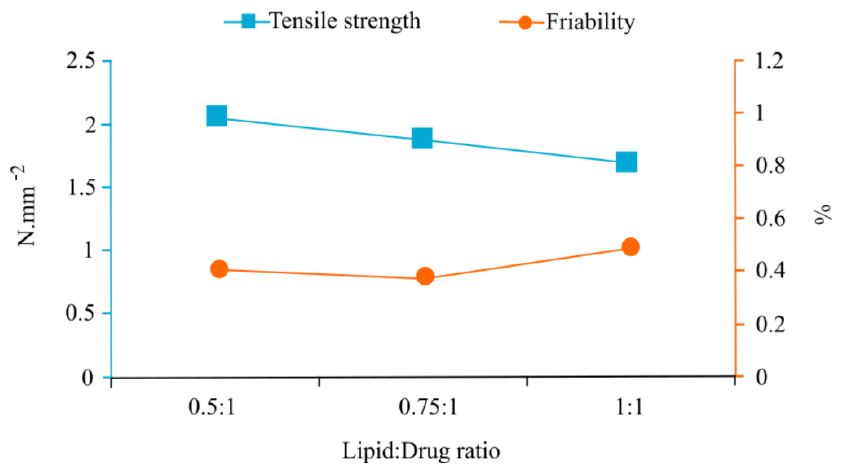
Figure 1. Dual-axis graph comparing lipid:drug ratio as a factor considering tensile strength (N · mm − 2 ) on the left y -axis and friability (%) on the right y -axis. Moreover, the 0.5:1 lipid:drug ratio produced tablets with the highest average tensile strength (2.084 N · mm − 2 ) and an adequately low friability (0.459%); however, overall, it exhibited the highest average mass variation (%RSD = 2.088%). The lower lipid content dictated higher filler content to achieve the target tablet weight, which could account for the higher %RSD-values due to the compaction properties and smaller particle size distribution of the fillers versus the solid lipid dispersions [10]. Although the 0.5:1 ratio percentage friability was in accordance with the BP standards [25], the higher tensile strength caused the tablets to be notably brittle, accounting for the higher percentage friability compared to that of the 0.75:1 ratio. The 1:1 ratio demonstrated the lowest tensile strength (1.735 N · mm − 2 ) and the highest percentage friability, implying that the reduction in tablet hardness caused these formulations to be more friable. Friability is a measure of a tablet’s resistance to abrasion during packaging, transportation and handling, and is strongly correlated with compression force. Highly friable tablets often relate to a low compression force, resulting in weak bonding between adjacent particles. Particles in closer proximity